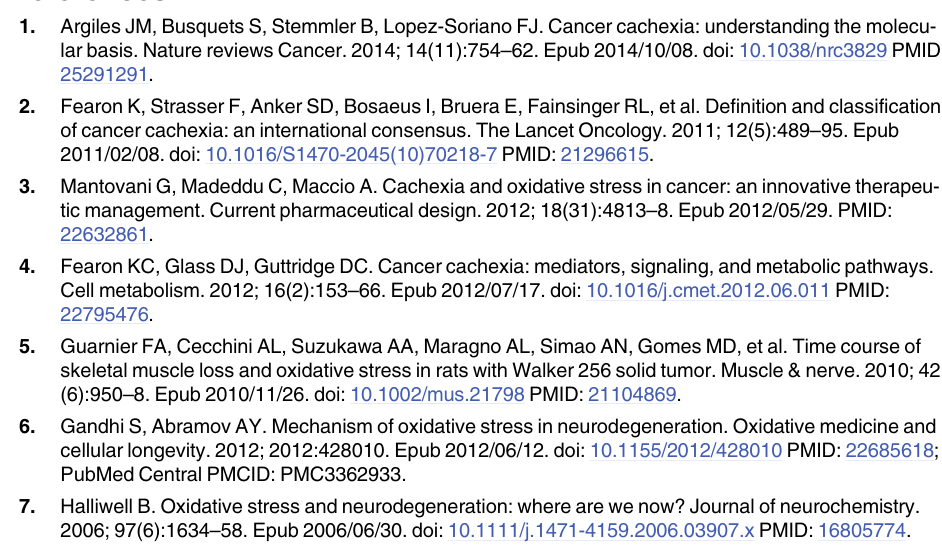
S2 Table. Neuronal density (uncorrected) of submucous neurons (neurons/cm 2 ) in the jeju- num and ileum. Experimental groups: control (C); control supplemented with 2% L-gluta- mine (CG); Walker-256 tumor (TW); and Walker-256 tumor supplemented with 2% L- glutamine (TWG). Uncorrected HuC/D-IR population (neurons/cm 2 ) and VIP-immunore- active subpopulation (neurons/cm 2 ) densities. The results are expressed as mean ± SEM (n = 8). Means followed by different letters in the same row are significantly different (p < 0.05) according to ANOVA (two-way) followed Tukey's post hoc test.